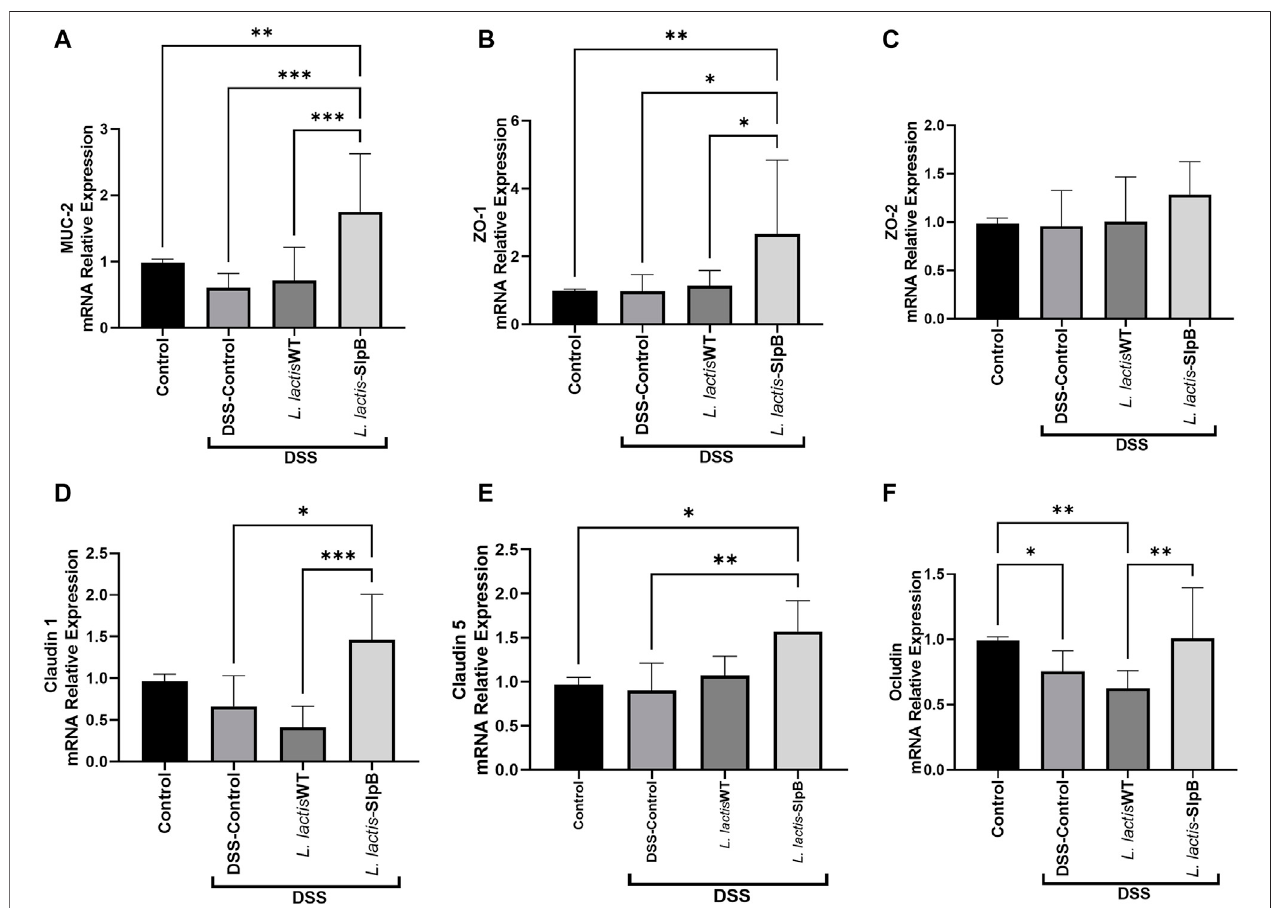
FIGURE 5 | L. lactis -SlpB increases the expression of genes involved in epithelial barrier protection. Quanti fi cation of the expression of the genes Mucin 2 ( muc2 ) (A) ,ZonulaOccludes1( zo-1 ) (B) ,ZonulaOccludes2( zo-2 ) (C) ,Claudin-1( cln-1 ) (D) ,Claudin-5( cln-5 ) (E) ,andOccludin( ocln ) (F) ,inthemicecolon,isshown.One-way ANOVA and Tukey ’ s post - hoc tests were used for multiple comparisons. The data represent the mean ± SD of six mice per group. Asterisks represent statistically signi fi cant differences as follows: p p < 0.05, pp p < 0.01, ppp p < 0.001, pppp p < 0.0001.